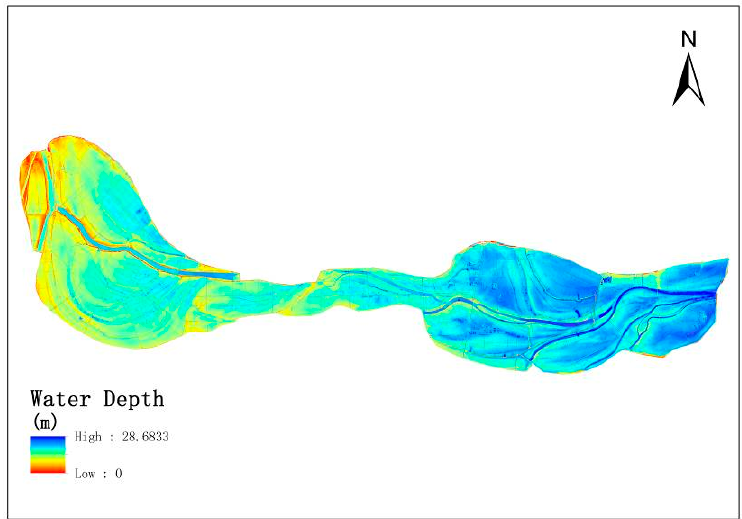
Figure 8. Calculated flood depth.